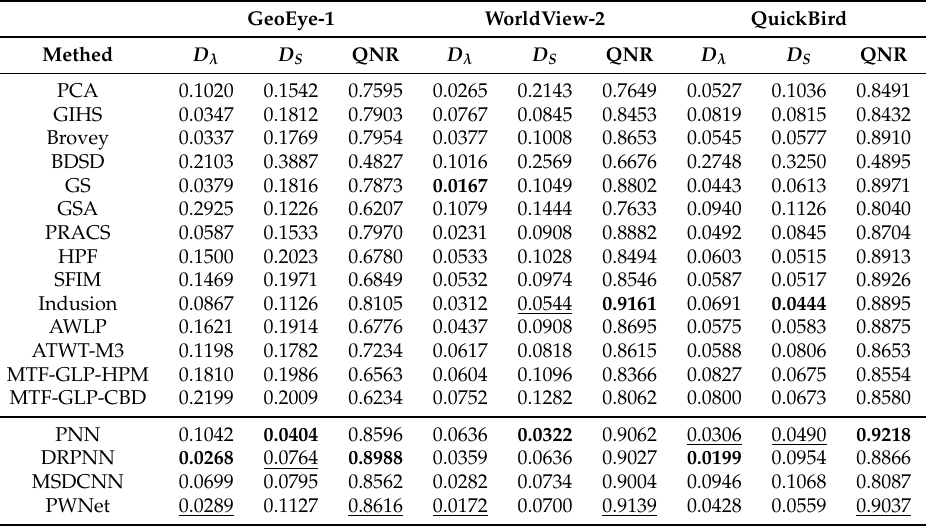
Table 9. Performance comparison on three test data sets at full resolution. The best and second best results are highlighted in bold and underlined,